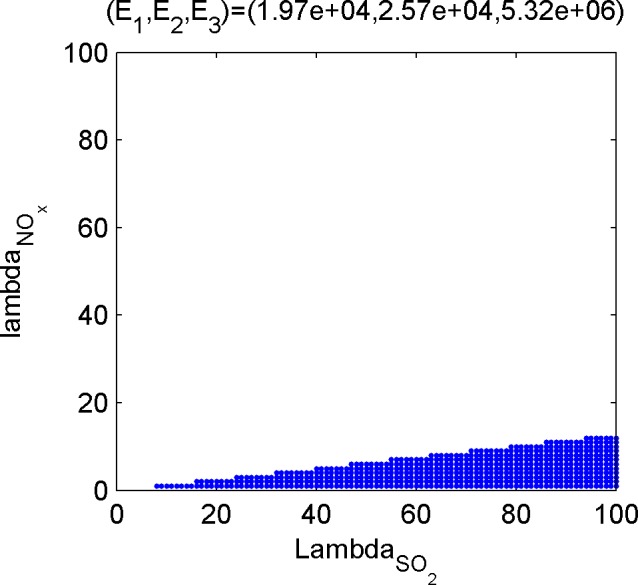
The dominant set relevant for (E1,E2,E3) = (1.97e+04,2.57e+04,5.32e+06).